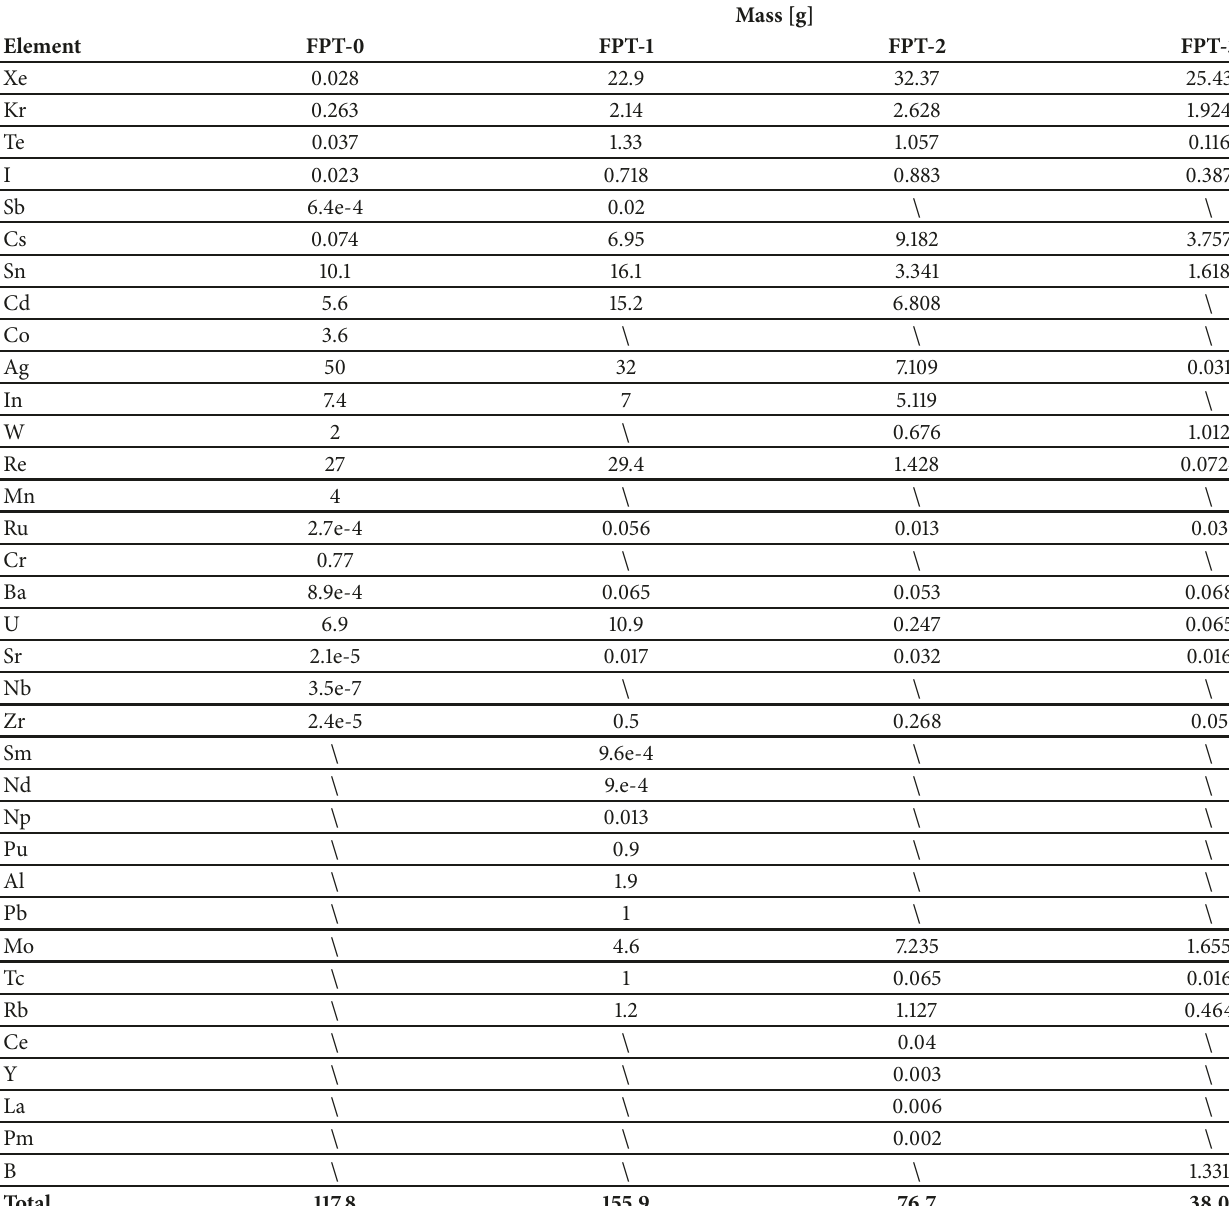
Table 4: Amount of FP and SM flowing into the CV during the Ph´ebus FPT tests.